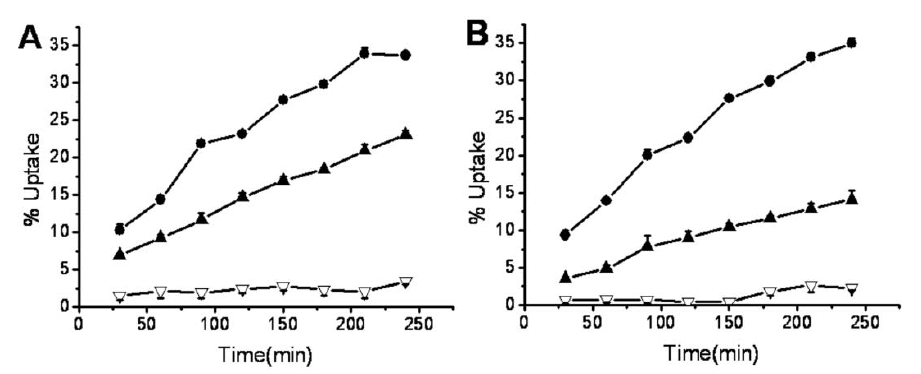
Figure 4. The anoxic uptakes of 99m Tc -1 ( A ) and 99m Tc -2 ( B ) in S180 cells at 4  C (blank triangle), 25  C (black triangle) and 37  C (black